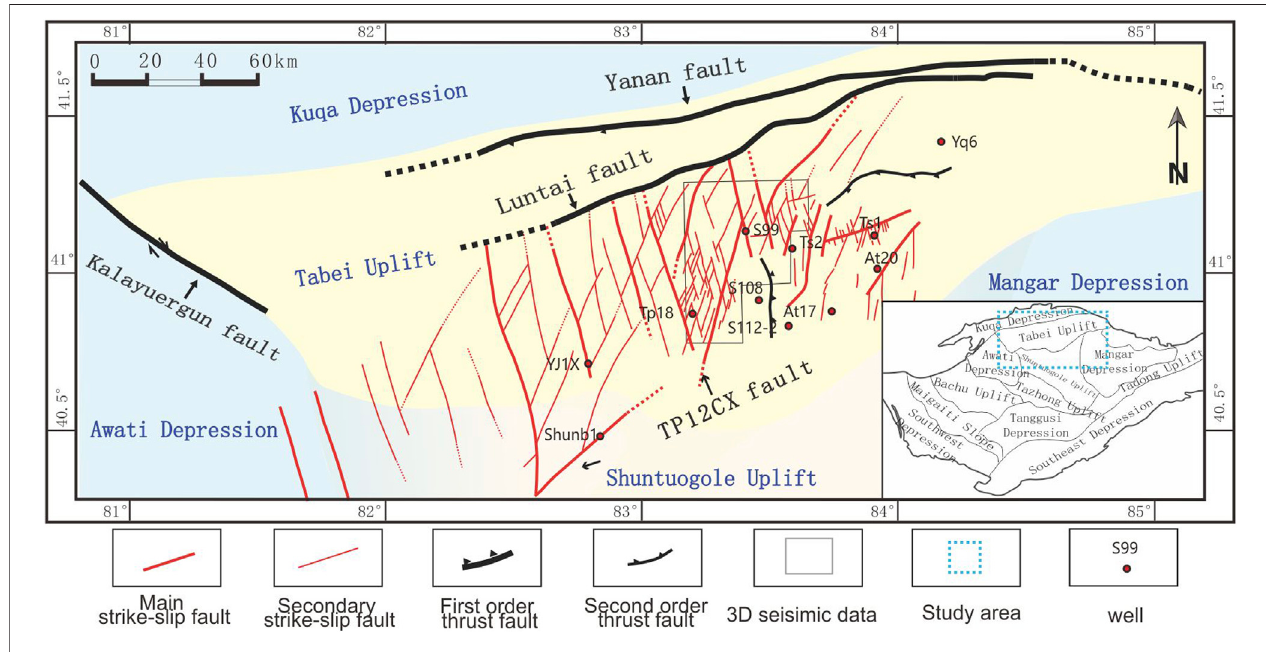
FIGURE 1 | Location map of TP12CX fault structure